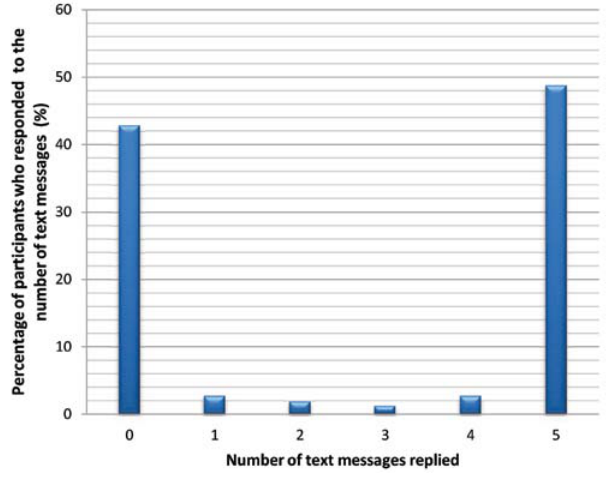
Figure 2. Percentage of mothers who replied to different numbers of text